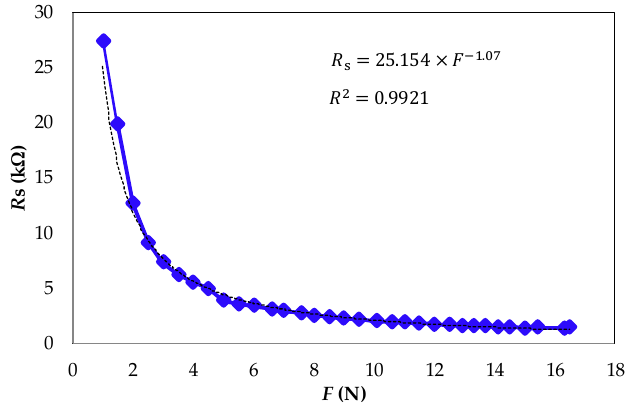
Figure 3. Experimental response of the FSR- 402 when force is applied to the sensor’s surface.